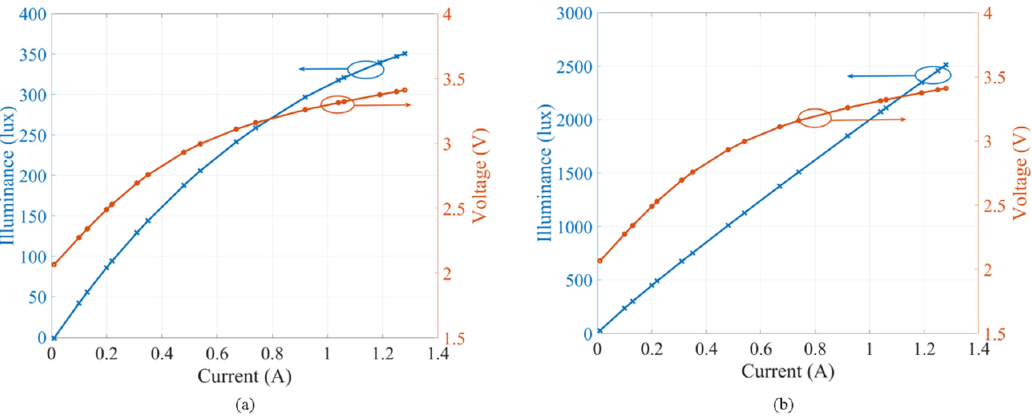
Figure 3. The L lux ‐ I ‐ V curves of the multiple ‐ input multiple ‐ output ‐ optical camera communications (MIMO ‐ OCC) Tx unit: ( a ) with the diffuser attached; and ( b ) without the